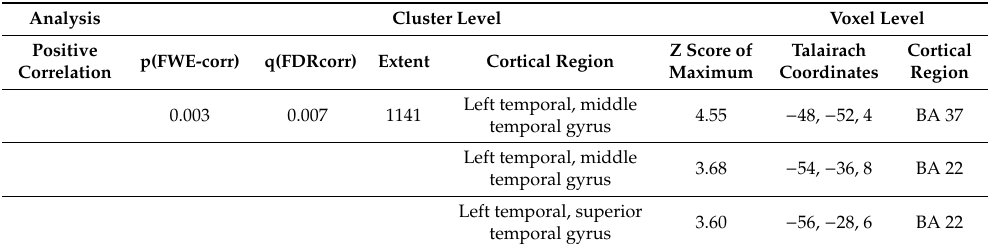
Figure 1. 3D rendering of the results of statistical parametric mapping analyses between (18F)FDG uptake and performance in RAVLT immediate that shows a positive correlation in a large portion of the left temporal lobe (Brodmann area 37 and Brodmann area BA22): ( a ) posterior view; ( b ) left lateral view. Table 3. A general overview of statistical parametric mapping analyses that detected a positive correlation in Brodmann area (BA) 37 and Brodmann area 22 of FDG uptake and performance in RAVL immediate test. The Brodmann areas were then identified at a range of 0 to 3 mm from the corrected Talairach coordinates of the SPM output isocentres. A statistical height threshold was equal to or lower than p < 0.001 at both clusters, and voxel-level was accepted as significant. We considered as significant a cluster extension of more than 125 contiguous voxels.